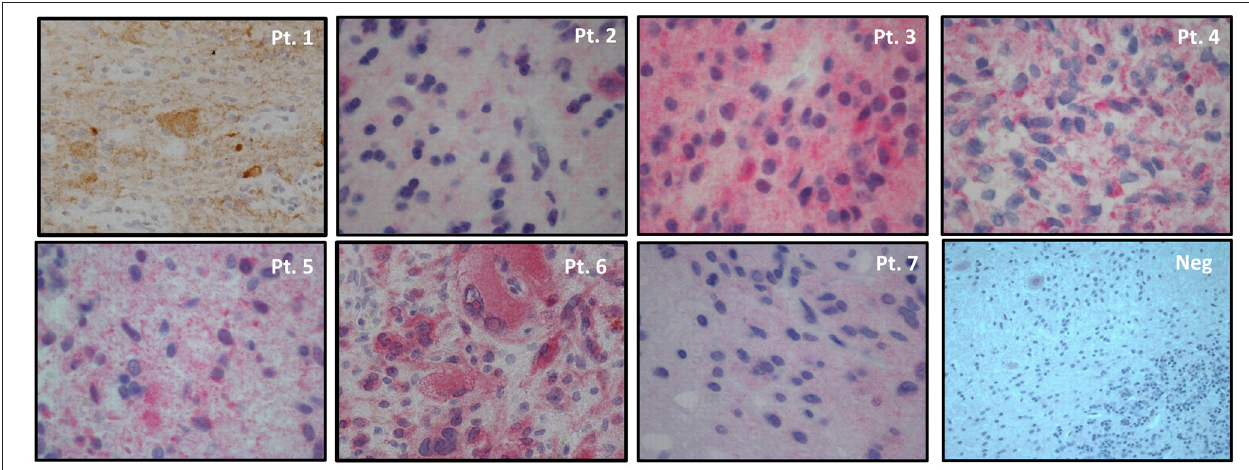
FIGURE 1 | BRAF V600E immunohistochemistry in tumor samples of patients’ series and in normal cerebellar parenchyma (small neurons of cortical molecular layer, Purkinje cells and underlining white mater resulted negative). Magnifications: Pt. 1 20x, Pts. 2-7 40x, Neg. 20x. 3,3 ′ -diaminobenzidine-tetrahydrochloride-dihydrate (DAB) substrate for Pt.1 and alkaline phosphatase substrate for Pts. 2-7 and negative control. Hematoxylin counterstain in all samples.